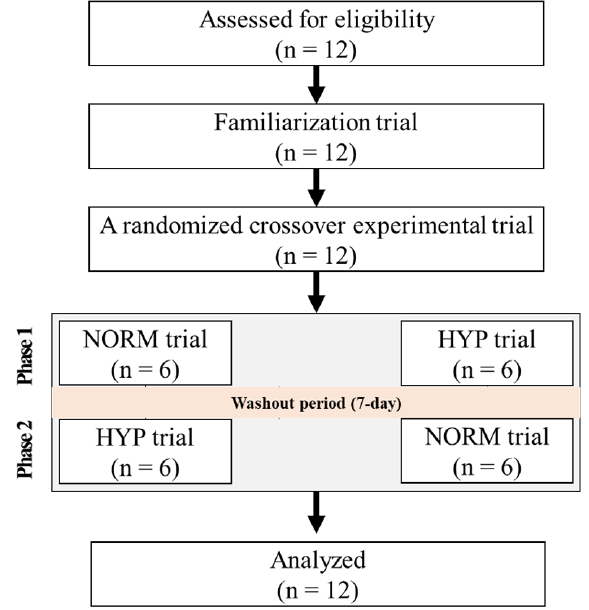
Figure 1. The flow diagram of the consolidated standards of reporting the trial. NORM: endurance exercise under normoxia; HYP: endurance exercise under moderate hypoxia (526 mmHg, simulated 3000 m).